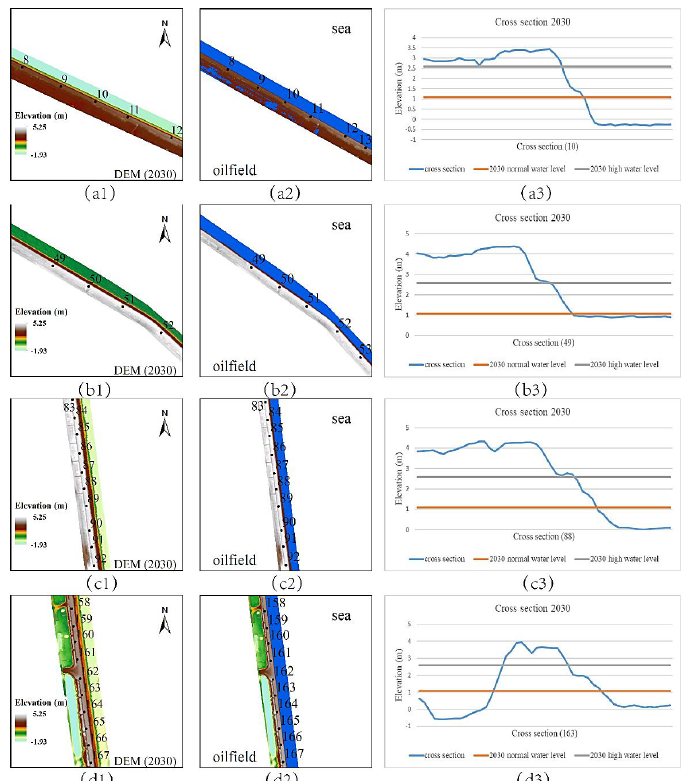
Figure 27. Cross section of the dam and 2D inundation diagram for 2030. The first column shows the DEM of four different parts of the dam in 2030, and the second column indicates the inundation range of the dam due to the highest sea-level (2.58 m), shaded in blue. The third column represents a cross section of the dam at points 10, 49, 88 and 163, in which the right direction is seaward.